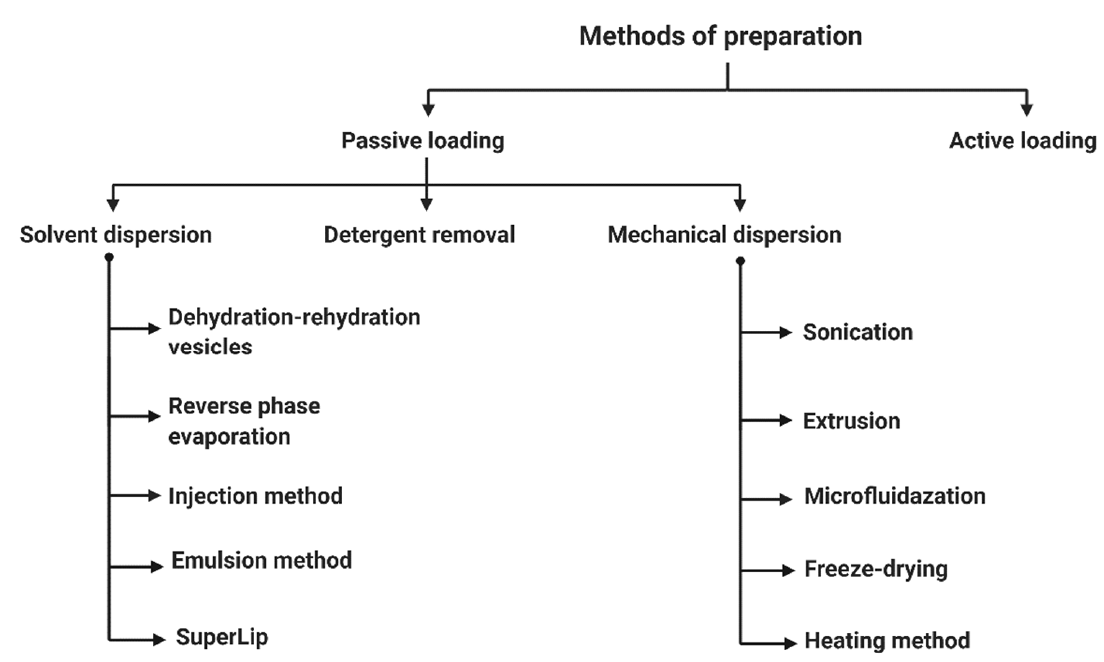
Figure 2. Methods of liposomes preparation.